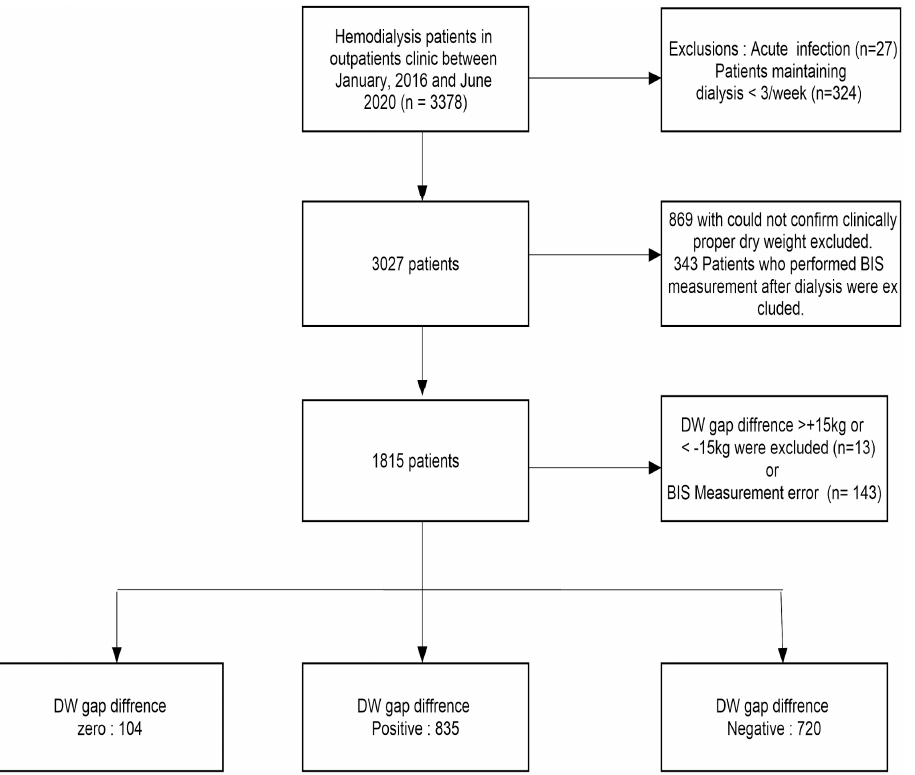
Figure 1. Study population.